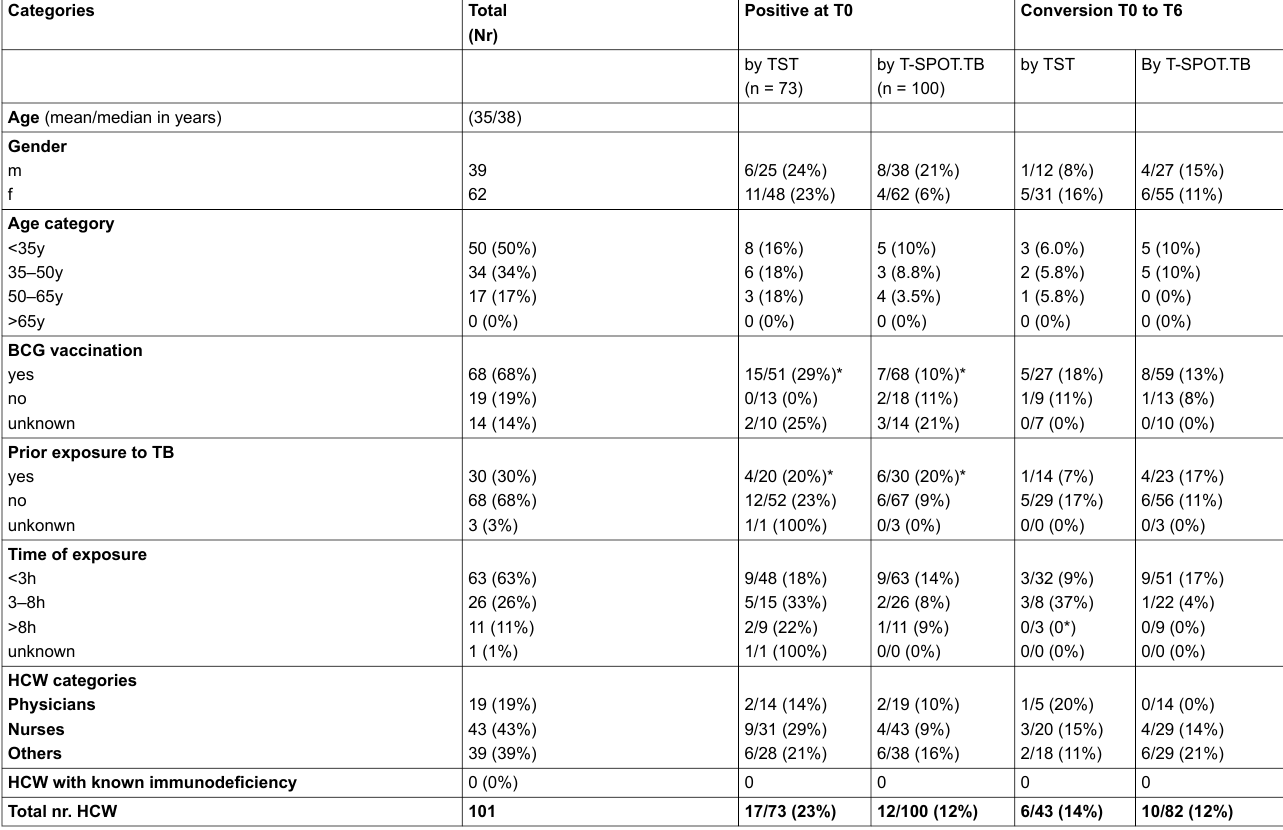
Table 1: Study population and distribution of positive test results (TST and T-SPOT.TB) at initial screening and at control (by frequency of positivity related to number of tests performed). The risk factors for TB infection prior to the current exposure were defined as: 1) birth in a country with a high prevalence of TB. 2) travel in such countries for more than six months. 3) previous exposure to any person known to have TB. Immunodeficiency was defined as having HIV/AIDS, solid or bone marrow transplantation or any other immunosuppressive drug (steroids, anti-TNF, etc). *OR and 95%-CI were calculated and the results are presented in the